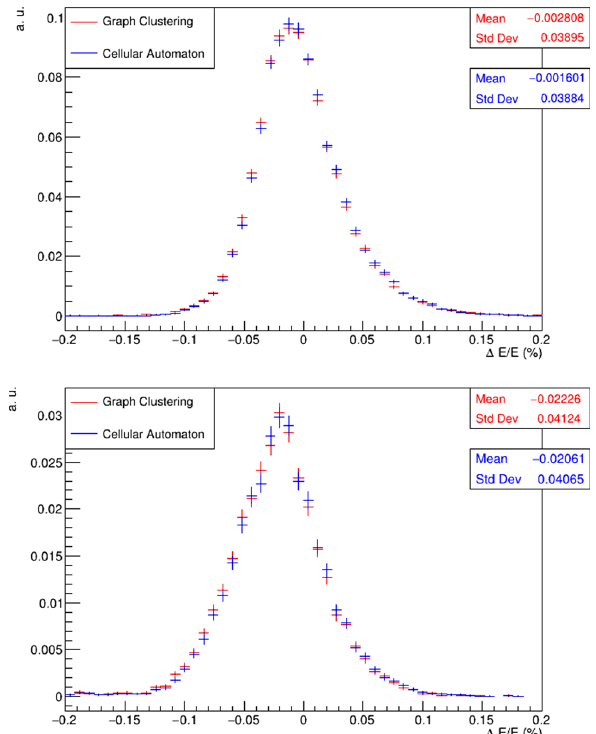
Fig. 5 Normalized histograms of the energy resolution with no cor- rections for clusters with a match fraction over 0 . 9 using γ samples in the top plot and π 0 samples in the bottom plot